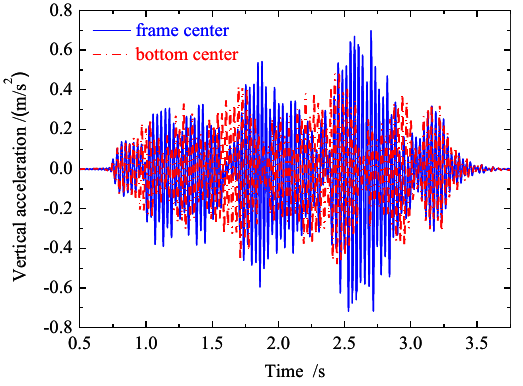
Fig. 11 The vertical acceleration of at-ground structure (50-Hz low- pass